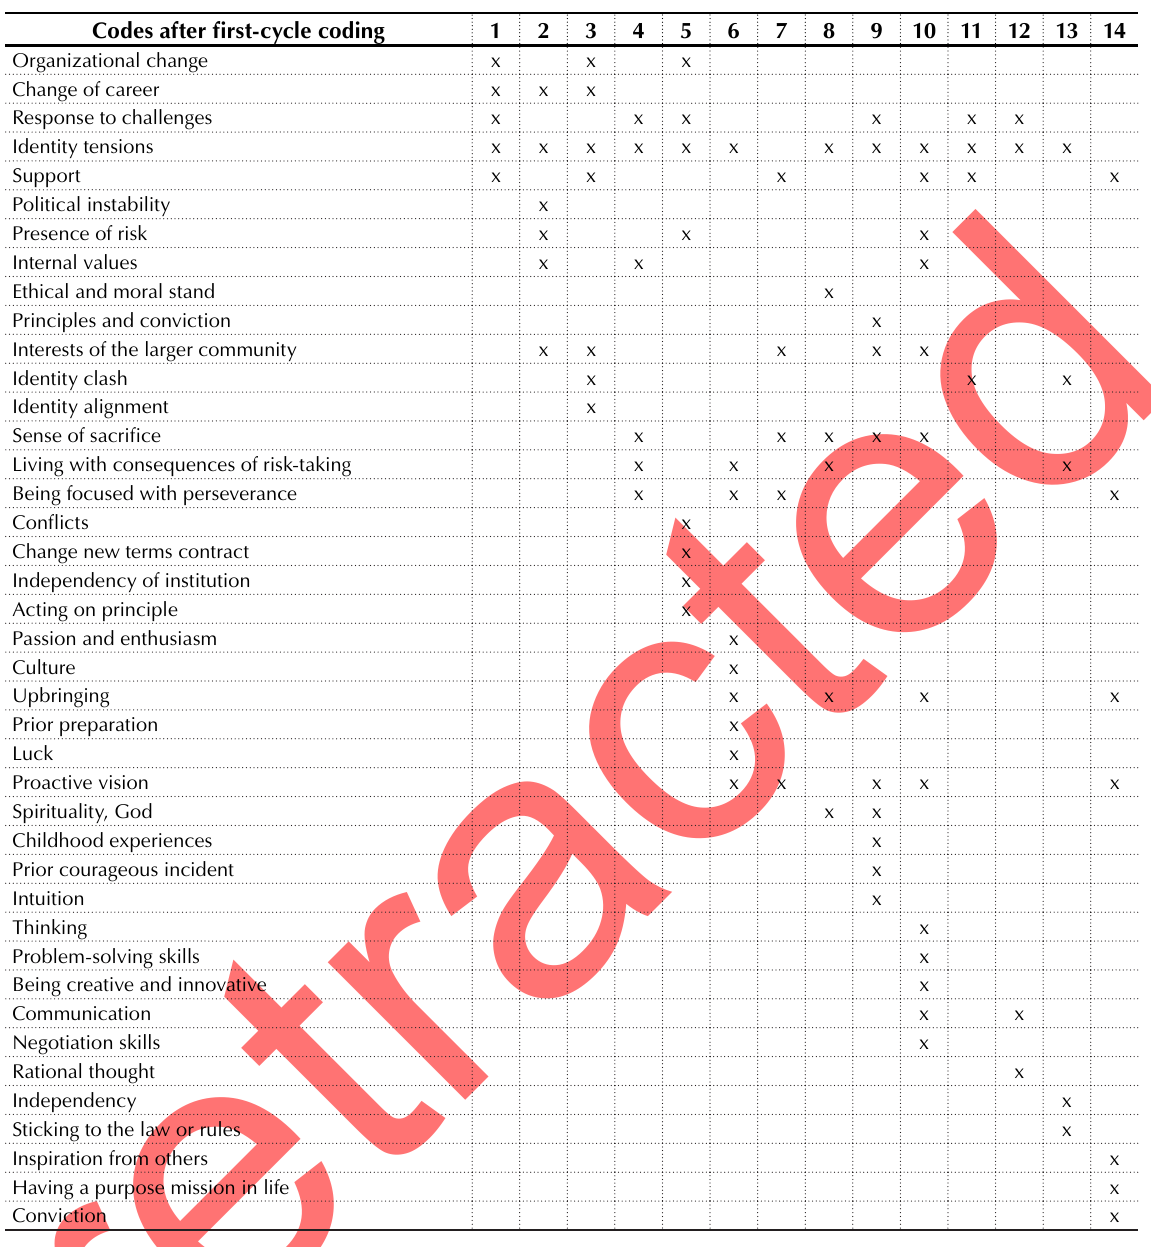
Table 1. Summary of the first cycle